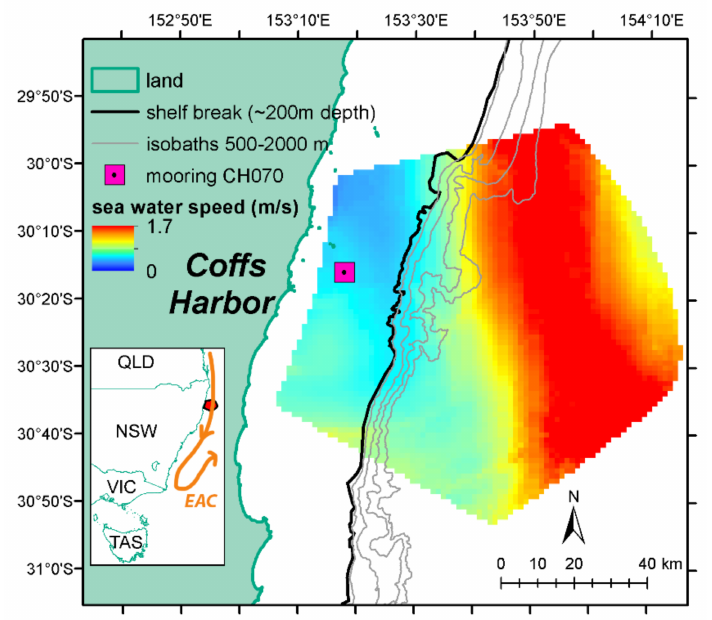
Figure 1. The bottom left panel depicts the radar coverage (in red) off the north NSW coast. The main figure shows the study area off Coffs Harbor, NSW, Australia, with HF radar observing area and the location of Mooring CH070 on the continental shelf (13 km off the coast). Daily averaged surface current speed for 11 January 2016 is shown by color